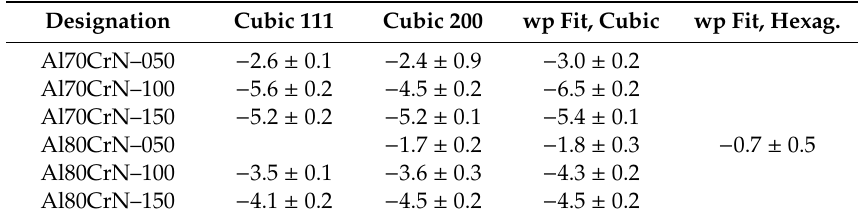
Table 3. Residual stress values obtained by conventional side inclination for cubic (111) and (200) reflections and wholepattern (wp) fitting, all values in GPa.